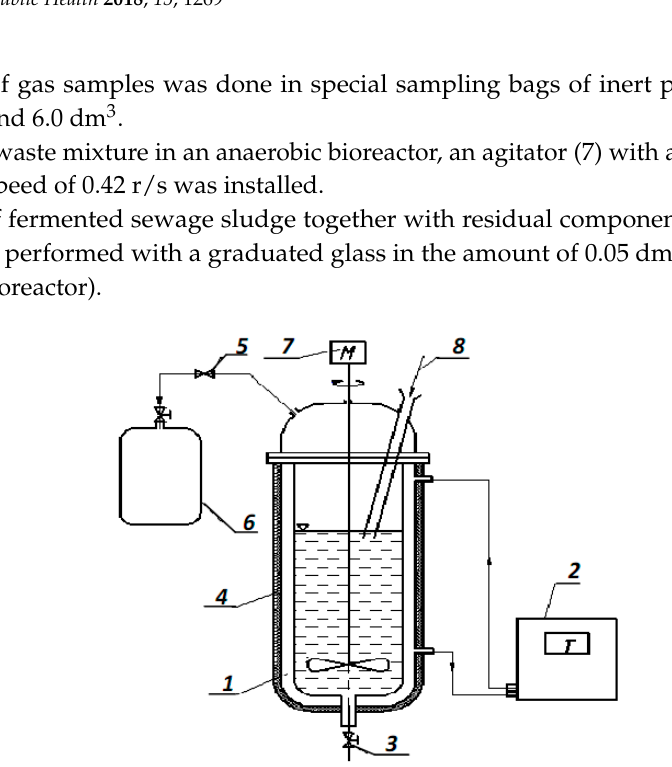
Figure 2. Experimental setup: 1—anaerobic bioreactor; 2—thermostat; 3—port for sludge removal; 4—insulation; 5—control valve; 6—biogas phase sampler; 7—mix device; 8—port for sewage sludge inflow and phosphogypsum loading.